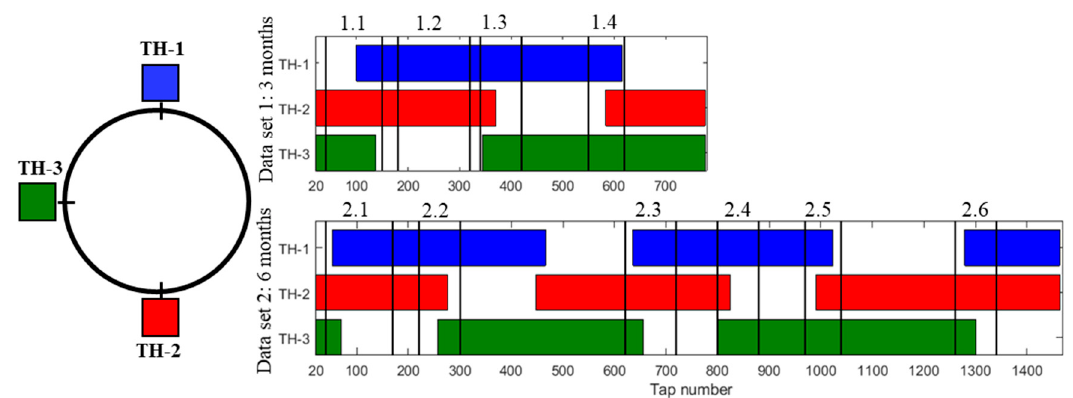
Figure 6. Taphole location in the reference furnace ( left ) and operating periods of the tapholes for the Data set 1 ( right top ) and Data set 2 ( right bottom ). The sub-periods studied in following sections are also indicated.